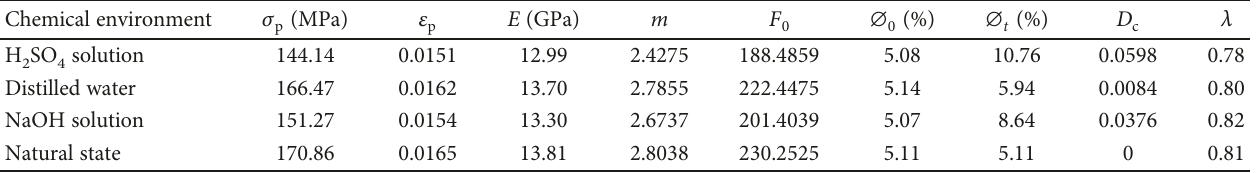
Table 5: Parameters of sandstone treated with di ff erent chemical corrosion (30